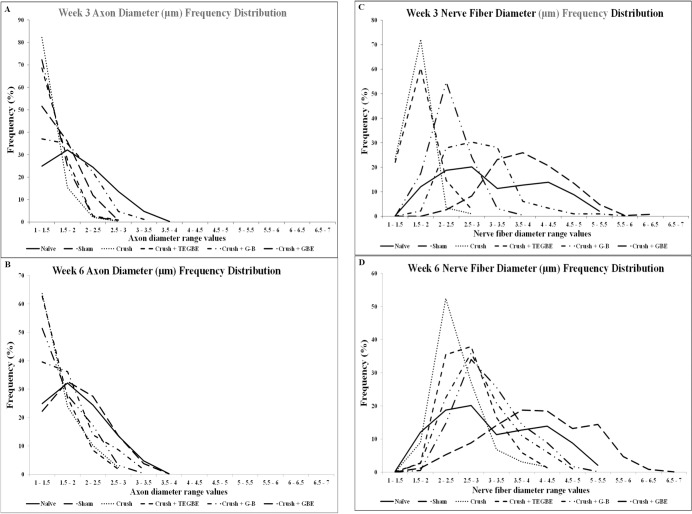
Axons and nerve fibers distribution.It is showing the frequency of the distributions of the diameters of myelinated axons and nerve fibers at week 3 (A, C) and week 6 (B, D) of sciatic crush nerve injury, respectively, which further confirm the above morphometric findings. The percentage frequency of the myelinated axons and nerve fibers (y-axis) were plotted against the diameter sizes (x-axis) ranging from 1 μm 10.5 μm from the experimental. Naive (n = 6) and sham (n = 12) groups show normal frequency distribution of myelinated axon (A, B) and nerve fiber (C, D) diameters unlike the crush group (n = 12) at 3 and 6 weeks post-injury which show a remarkable shift in the distribution of the axon and never fiber diameter sized to the left toward low range values compared to naive and sham animals. In general, all the treated groups showed a remarkable right shift in both axon and nerve fiber frequency distributions toward normalization. Interestingly, the G-B-treated group (n = 12) shows faster influence on the frequency distribution shift towards normal values compared to other treated groups at both time points.